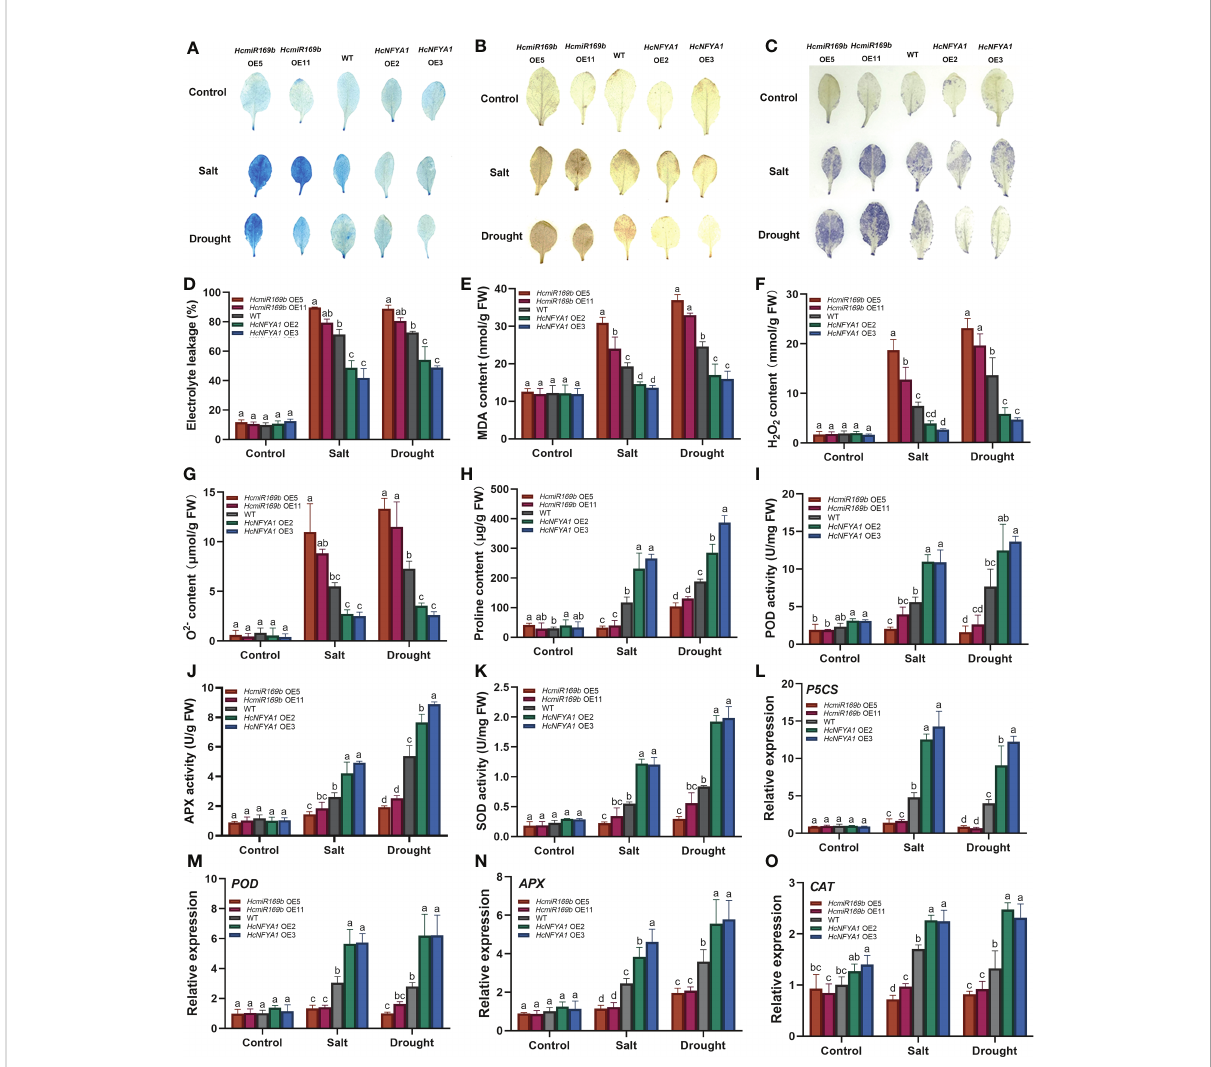
FIGURE 5 The performance of WT and two transgenic ( HcmiR169b , HcNFYA1 OE) Arabidopsis lines under salt and drought stress. (A – C) Evans blue (A) , DAB (B) and NBT (C) staining of adult Arabidopsis leaves under control, salt (300 mM NaCl) and drought (stop the irrigation) stress. (D) Electrolyte leakage assay. (E-H) MDA (E) , H 2 O 2 (F) , O − 2 (G) , proline (H) contents. (I – K) POD (I) , APX (J) , SOD (K) enzyme activities. (L – O) Relative expression of P5CS (L) , POD (M) , APX (N) , CAT (O) genes. All data represented the means ± SD of three biological replicates. Different letters indicated signi fi cant differences in the detected values of various types of Arabidopsis between treatments (Duncan ’ s multiple range test, p